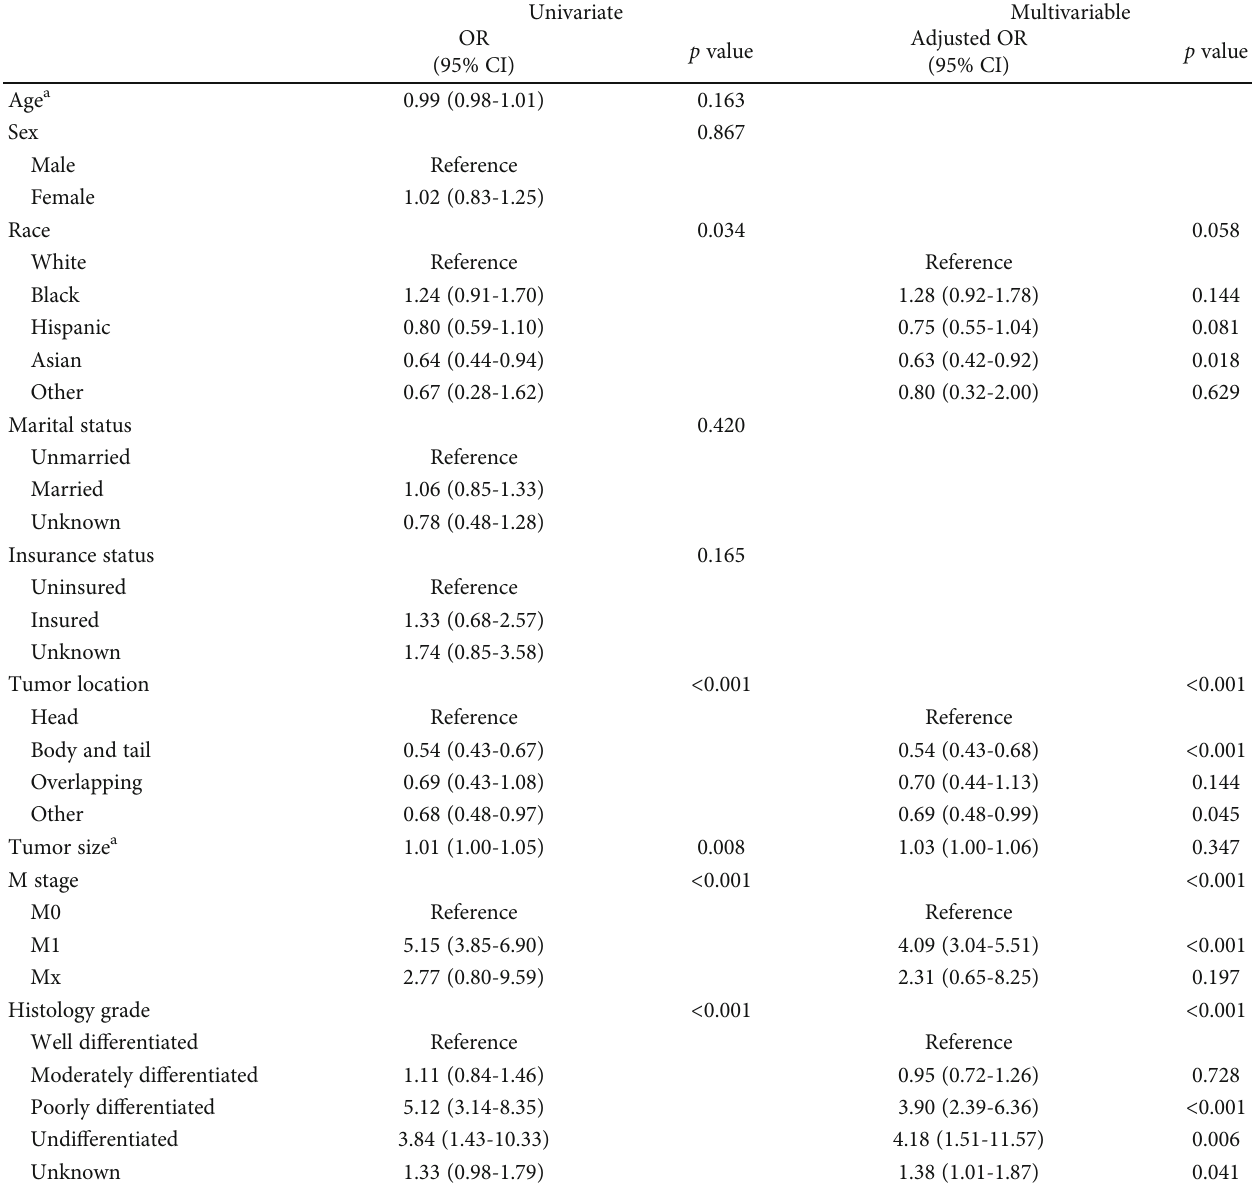
Table 2: Results of univariate and multivariable analysis for the possible factors of lymph node